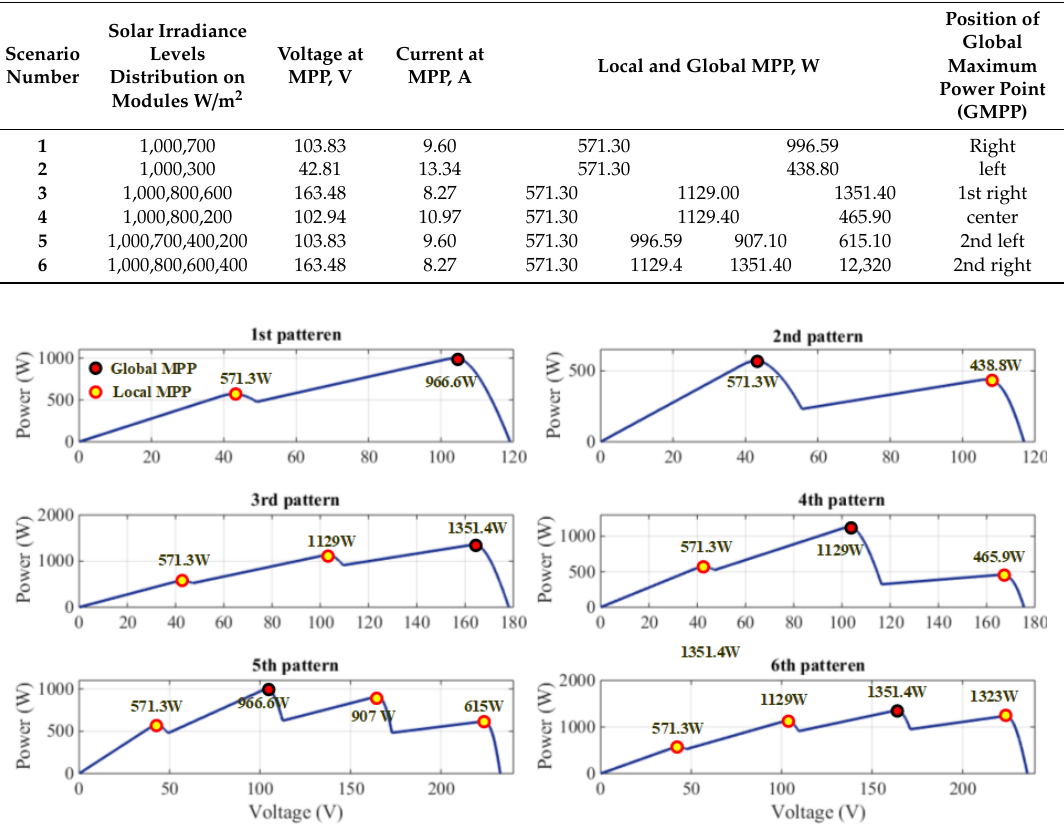
Figure 4. The P–V curves of the studied PV systems with different shadow patterns.